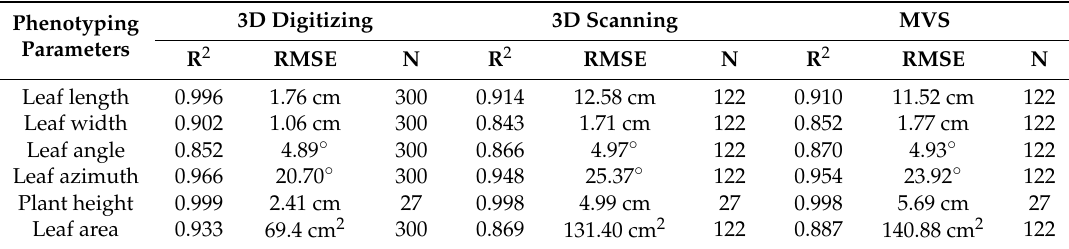
Figure 7. Phenotyping parameter evaluation derived by 3D scanning, MVS reconstruction, 3D digitizing, and manual measurement. The samples used contain all three hybrid plants in three growth stages. Evaluated parameters include ( A ) leaf length, ( B ) leaf width, ( C ) leaf inclination angle, ( D ) leaf azimuth, ( E ) leaf area, and ( F ) plant height. Table 3. Correlation coefficient (R 2 ) and root mean square error (RMSE) of phenotyping parameters derived by 3D scanning, MVS reconstruction, and 3D digitizing as presented in Figure 7.